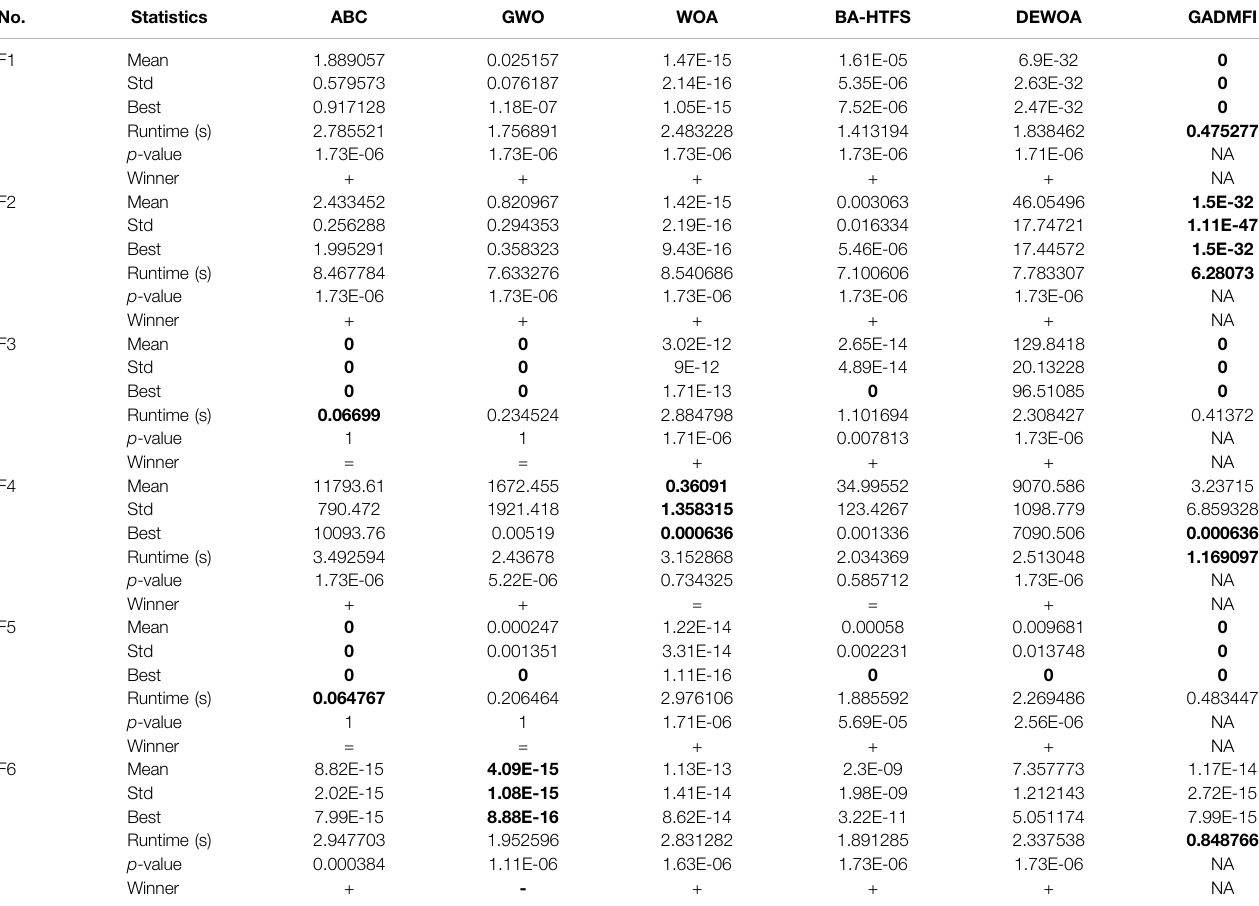
Bold digits are the best statistical performance measures of various